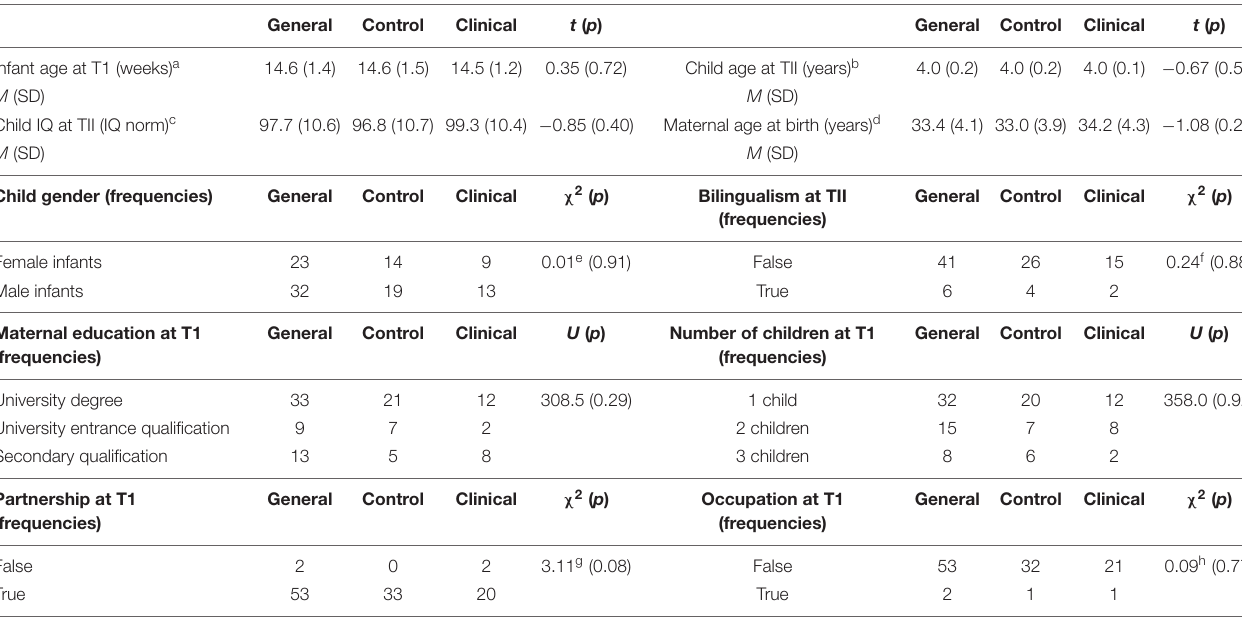
TABLE 1 | Maternal and child demographics and tests on comparability of subgroups. General Control